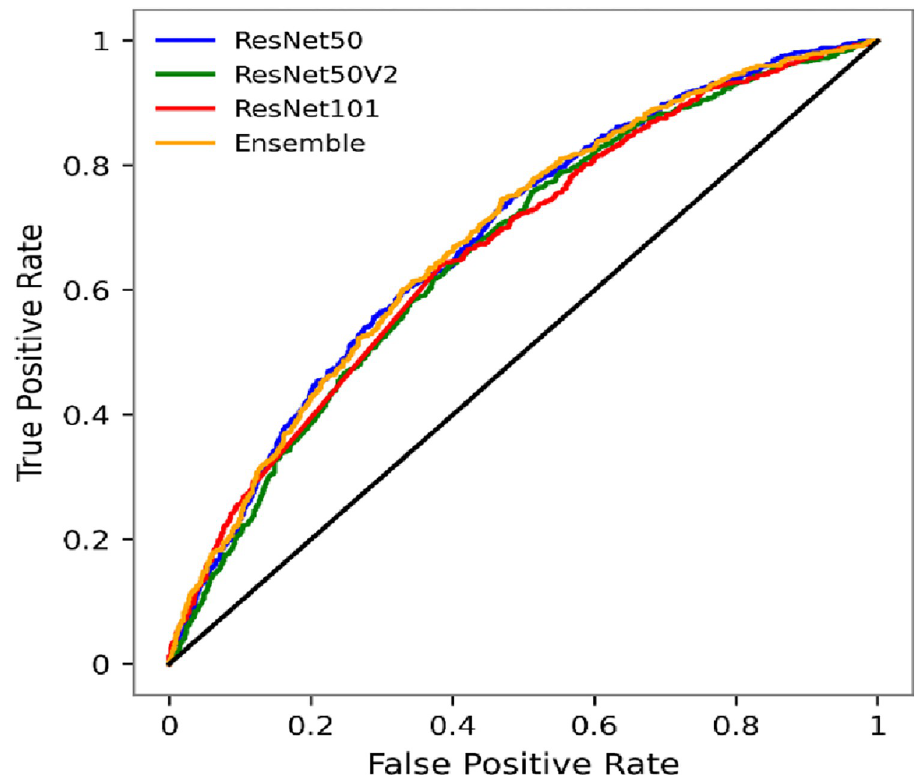
Fig 2. Comparison of CNN models ROC